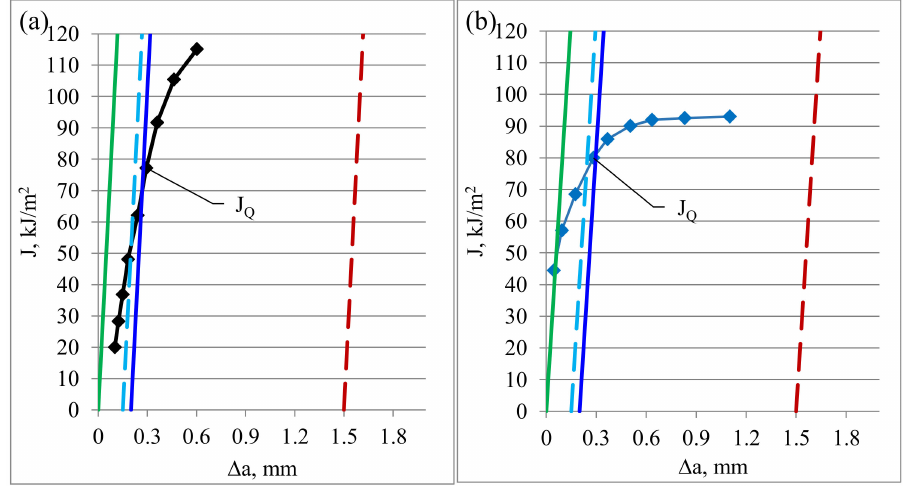
Figure 6. Shape of J–R curve for AA2519 aluminum alloy, ( a ) tested under ambient conditions and ( b ) tested under cryogenic